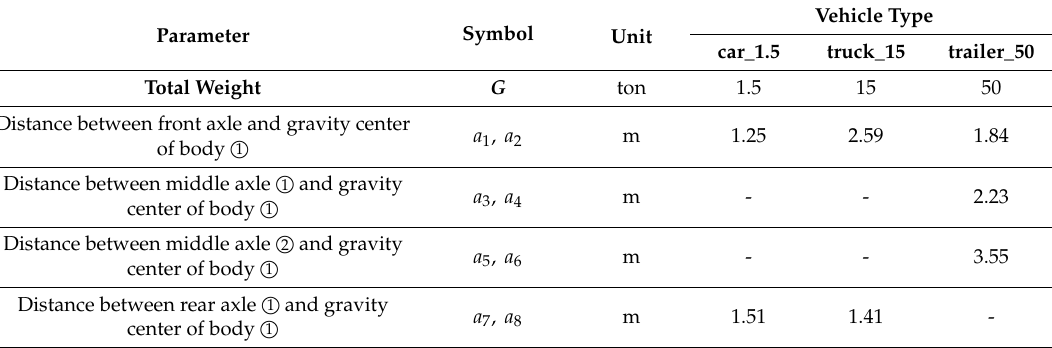
Table 6. Parameters of vehicles (the meaning of symbols can be observed in Figure 2).